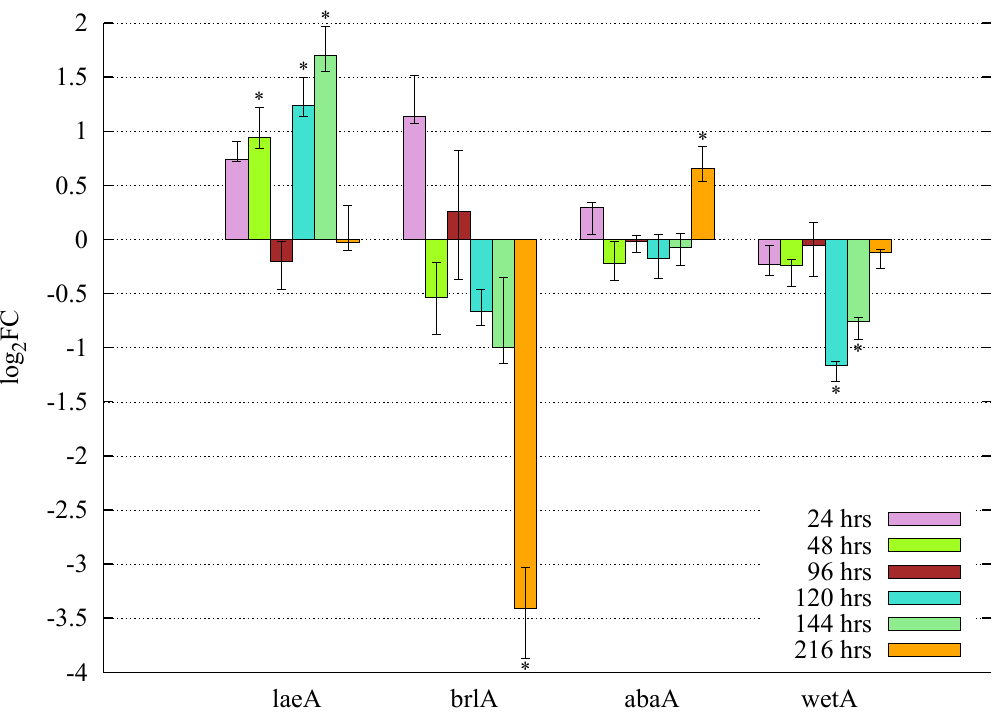
Figure 6. Butyrolactone I upregulates the A. terreus laeA ortholog and appears to play a role in the expression of the core conidiation regulator orthologs brlA , abaA and wetA . Exogenous butyrolactone I was added to the submerged culture of A. terreus MUCL 38669 at 24 h p.i. to the final concentration of 100 nM. Samples were analysed for gene expression using custom-designed microarrays as described in the Methods. The bars represent the median values of the log 2 FC of treated samples (butyrolactone I was added) vs. control samples (no butyrolactone I added), and the error bars represent the maxima and minima of these log 2 FC values. * At least one of the four technical replicates indicates statistically-significant differential expression in the three biological replicates (adjusted p -value ≤ 0.05 and | log 2 FC | ≥